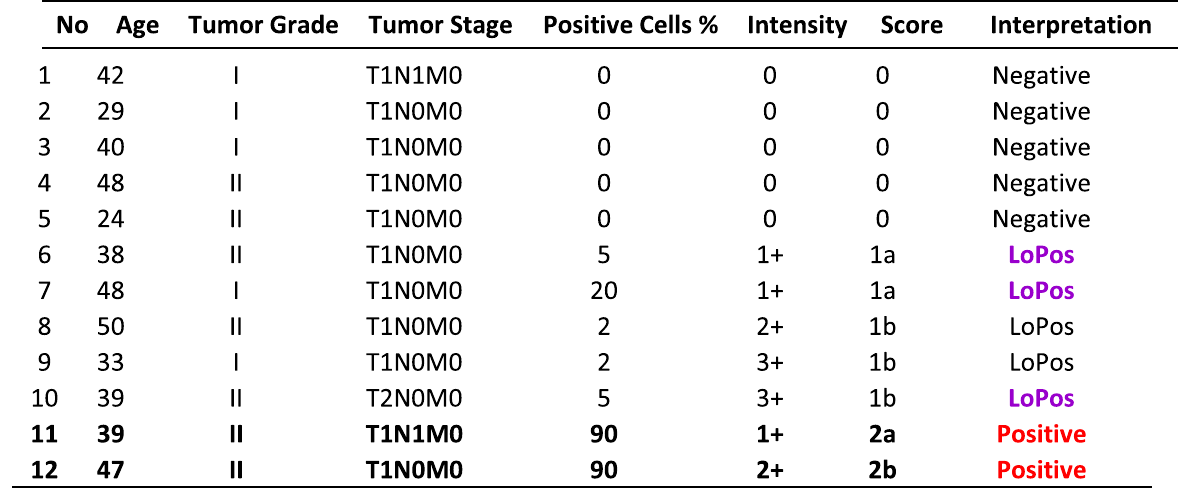
described in this study